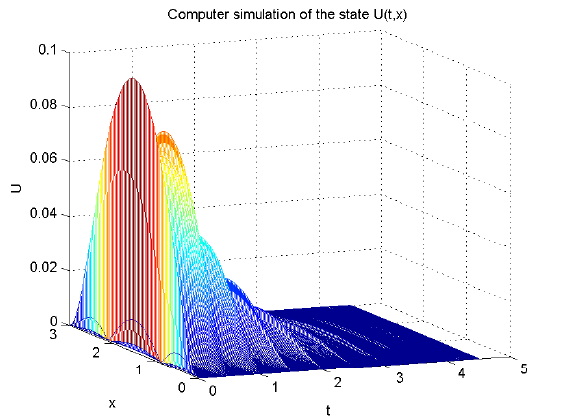
Figure 2. Dynamics of U ( t , x ) of System (9) under the Markov chain depicted in Figure